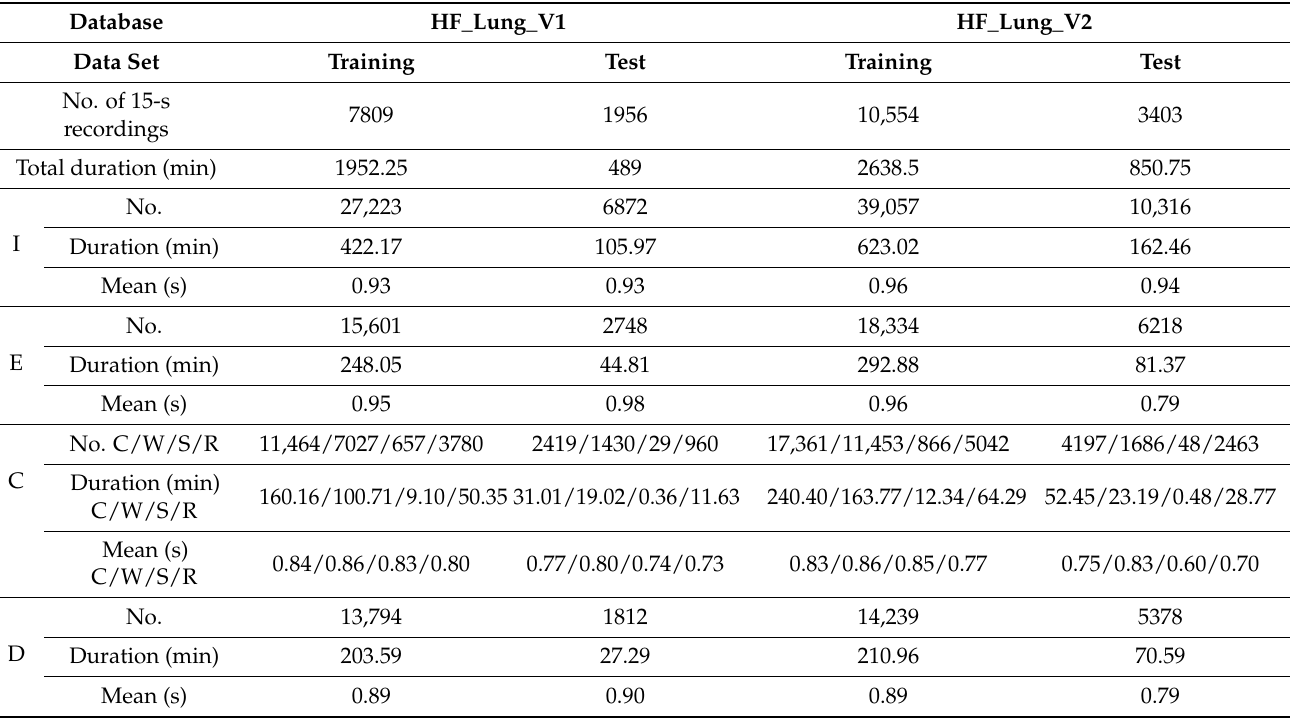
Table 3. Statistics of lung sound files and labels in the HF_Lung_V1 and HF_Lung_V2 databases grouped by data